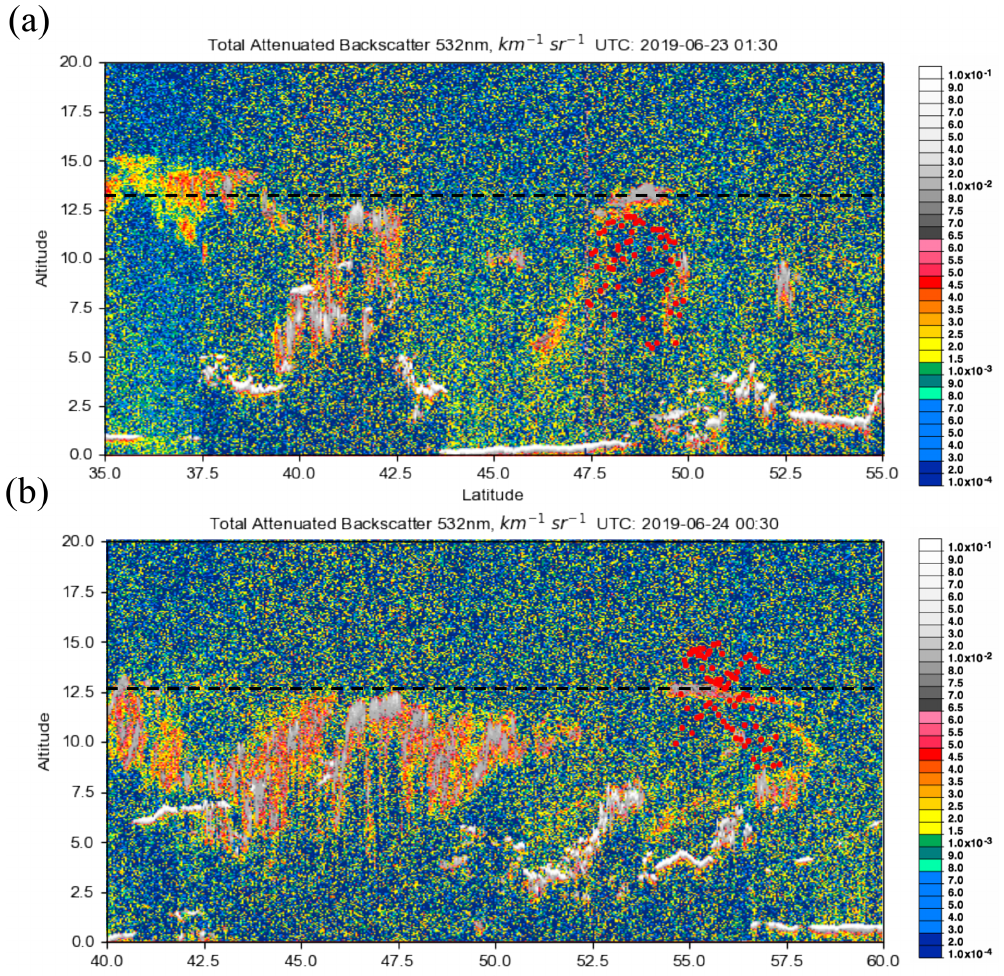
Figure 11. CALIPSO lidar 532nm attenuated backscatter for the Raikoke eruption on (a) 23 June and (b) 24 June 2019. The black dashed line symbolizes the height of the ash plume seen by CALIPSO, and red dots show the results from the OMI retrieval along CALIPSO’s flight path. The flyovers occurred shortly after 01:30 and 00:30UTC on 23 and 24 June, respectively, around the same time as